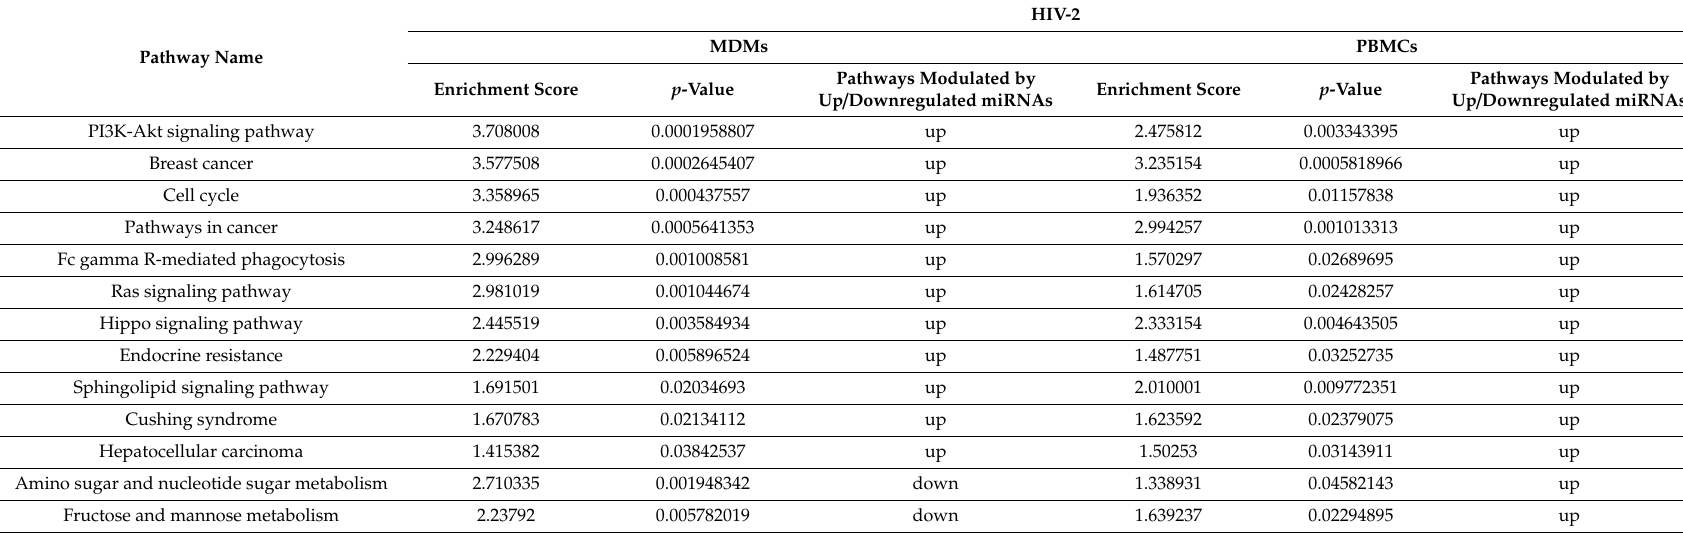
Table 5. Common pathways modulated by di ff erentially expressed miRNAs in HIV-2-infected MDMs and